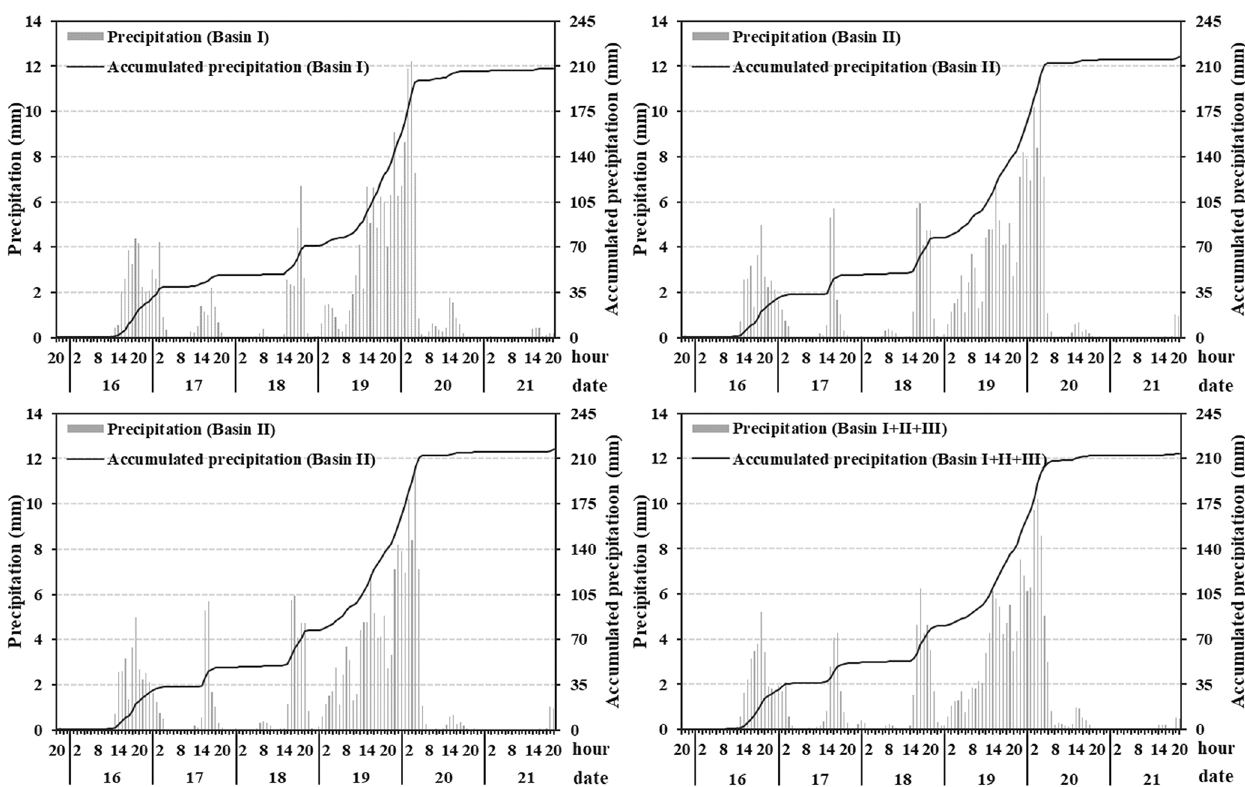
Figure 2. Distribution of hourly and accumulated precipitation in the upper reaches of the Oujiang River basin (basin I + II + III) and each sub-basin. (The gray column is hourly precipitation, and the black curve is accumulated precipitation. The precipitation time is from 20:00 on 15 August to 20:00 on 21 August 2014 (UTC +